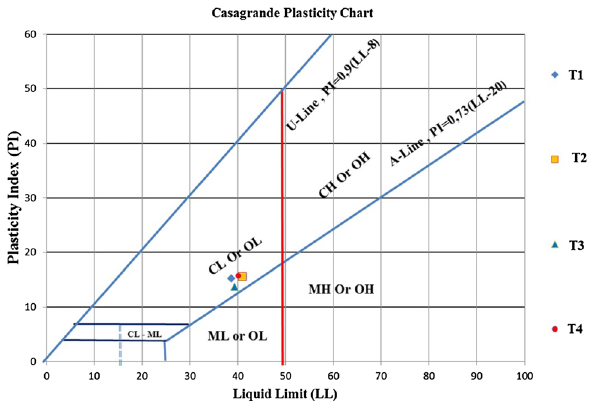
Fig. 12 Projection of the different four samples in the Casagrande plasticity chart